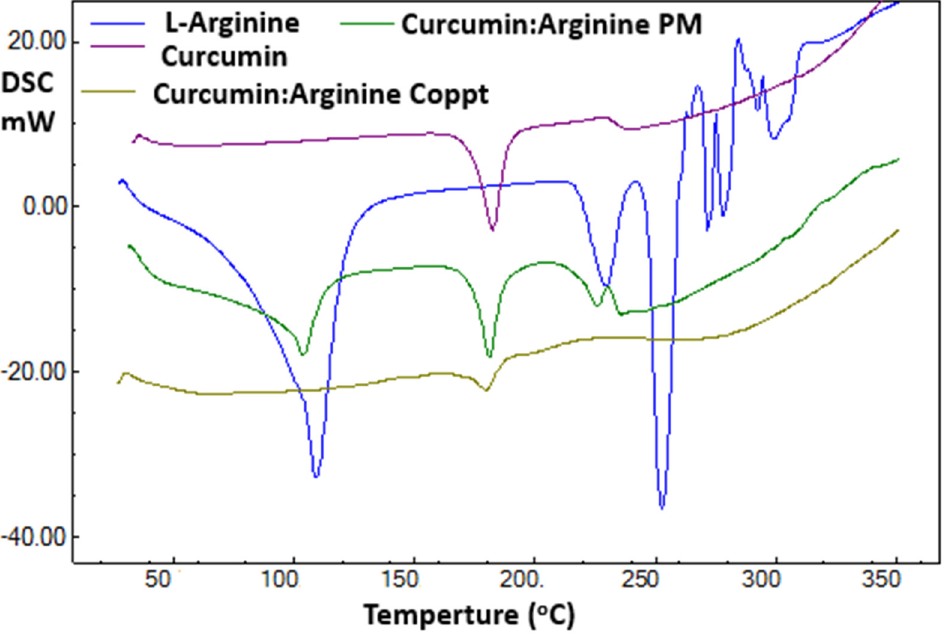
Figure 3. DSC thermal spectra of curcumin, curcumin-L-arginine physical mixture, and coprecipitated dispersion.